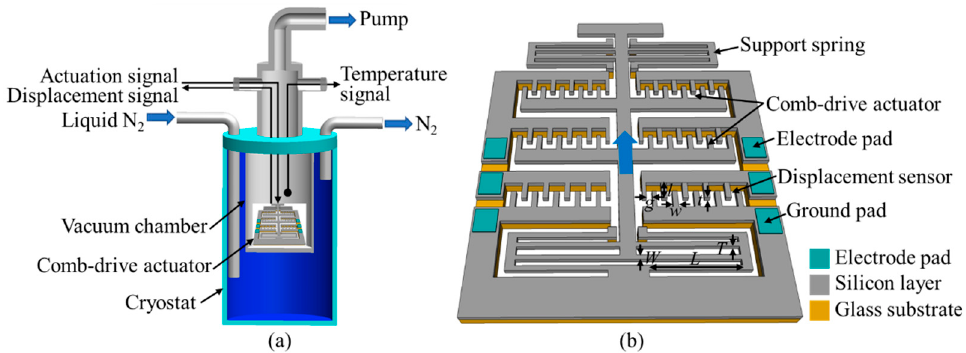
Figure 1. ( a ) Schematic of cryogenic setup for measuring the comb-drive actuator at low temperatures; ( b ) schematic of the one-axis comb-drive actuator fabricated from the heterogeneous struc- ture.